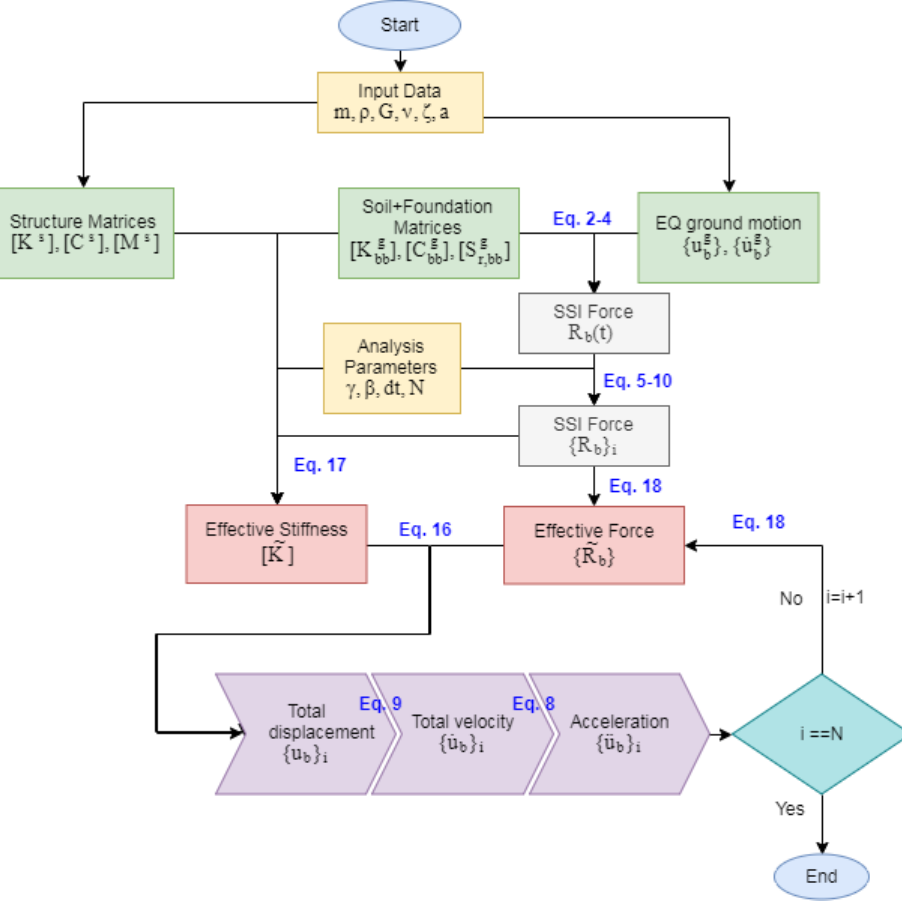
Figure 1. Flow chart of analysis of SSI system for EQ base